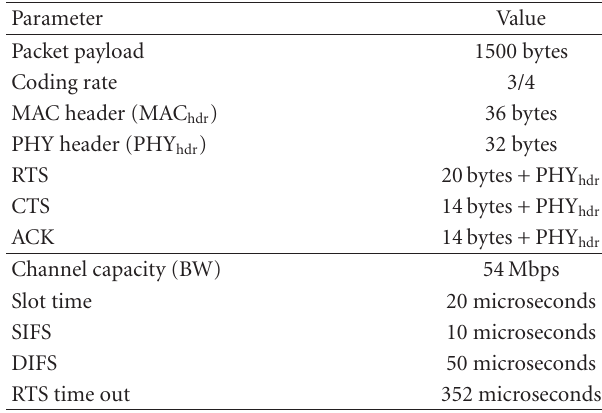
Table 4: DSSS-OFDM system parameters for IEEE 802.11e used to obtain numerical